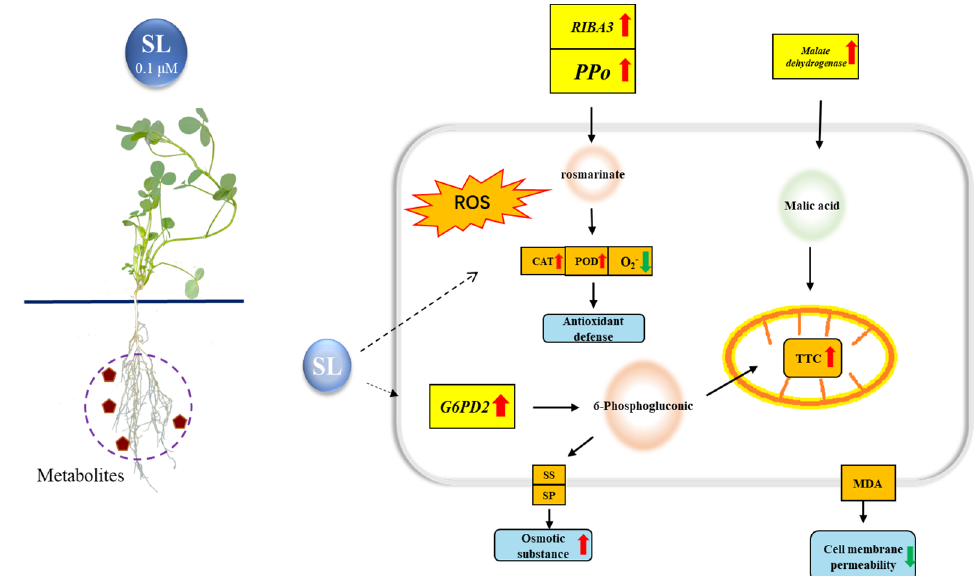
Figure 9. Summary of the changes in physiological characteristics, DEMs, and related genes of alfalfa roots under drought stress and with the addition of rac − GR24 for drought tolerance. Orange circles represent rosmarinate and 6 − Phosphogluconic, which were upregulated, while the green circle represents malic acid, which was downregulated.